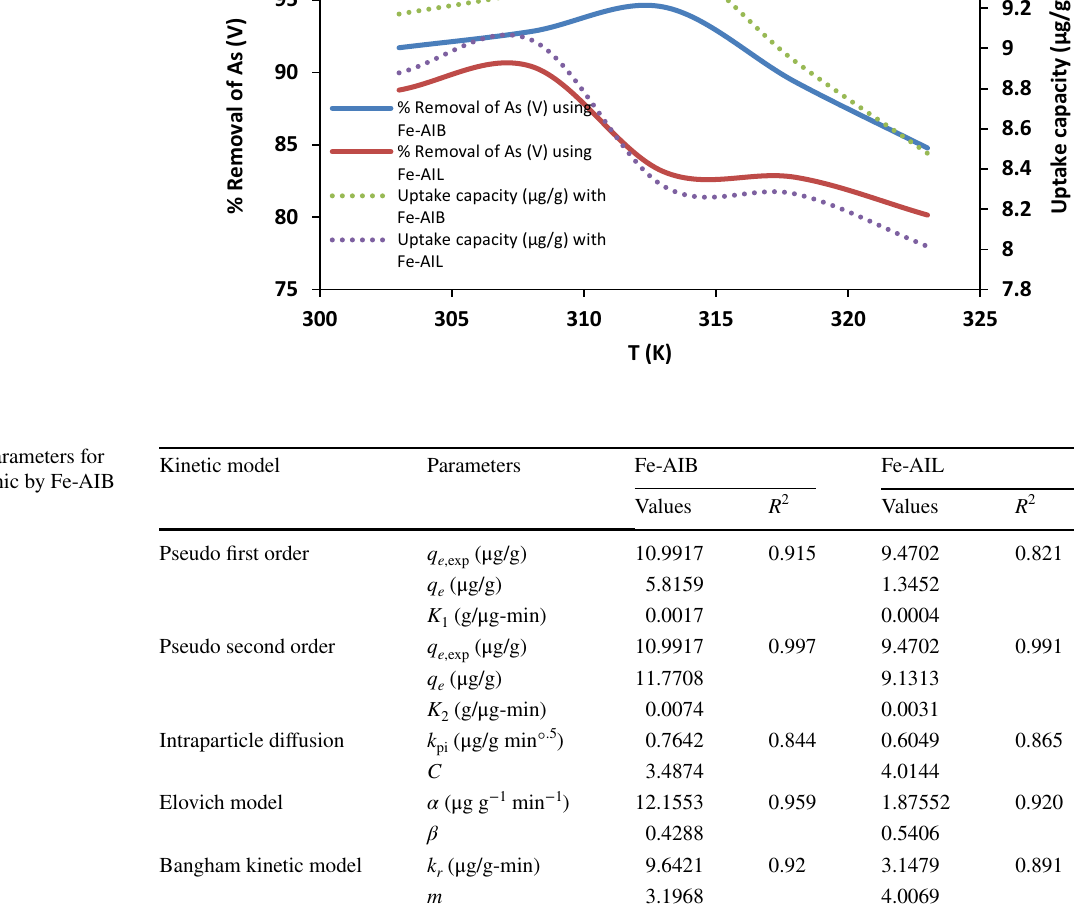
Fig. 13 Effect of temperature on adsorption of As (V) by Fe-AIB and Fe-AIL